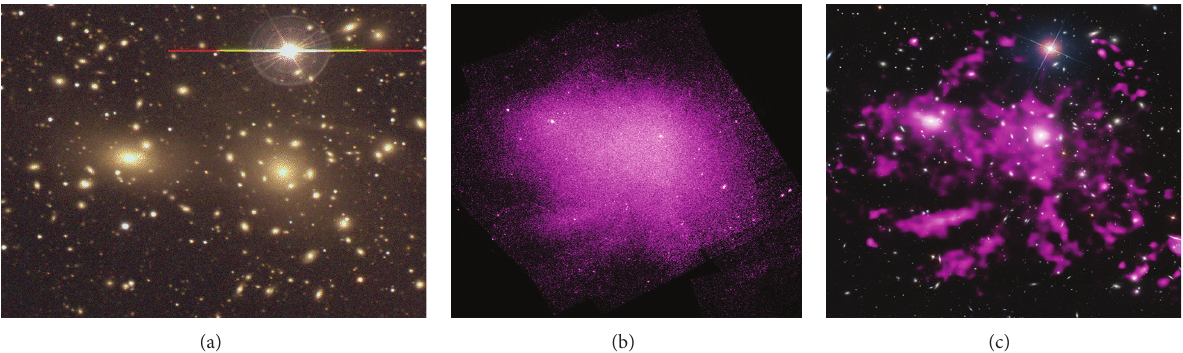
Figure 3: The Coma Cluster of galaxies. An optical image (a) shows two giant galaxies near the center plus a number of smaller galaxies. The raw X-ray image (b) was taken by the Chandra X-Ray Observatory. The size of the optical and X-ray fields shown is about 600 kpc (2 million light years). (c) is an overlay of the optical image with a high contrast X-ray image that displays the regions with high X-ray surface brightness around two giant elliptical galaxies that dominate the cluster.